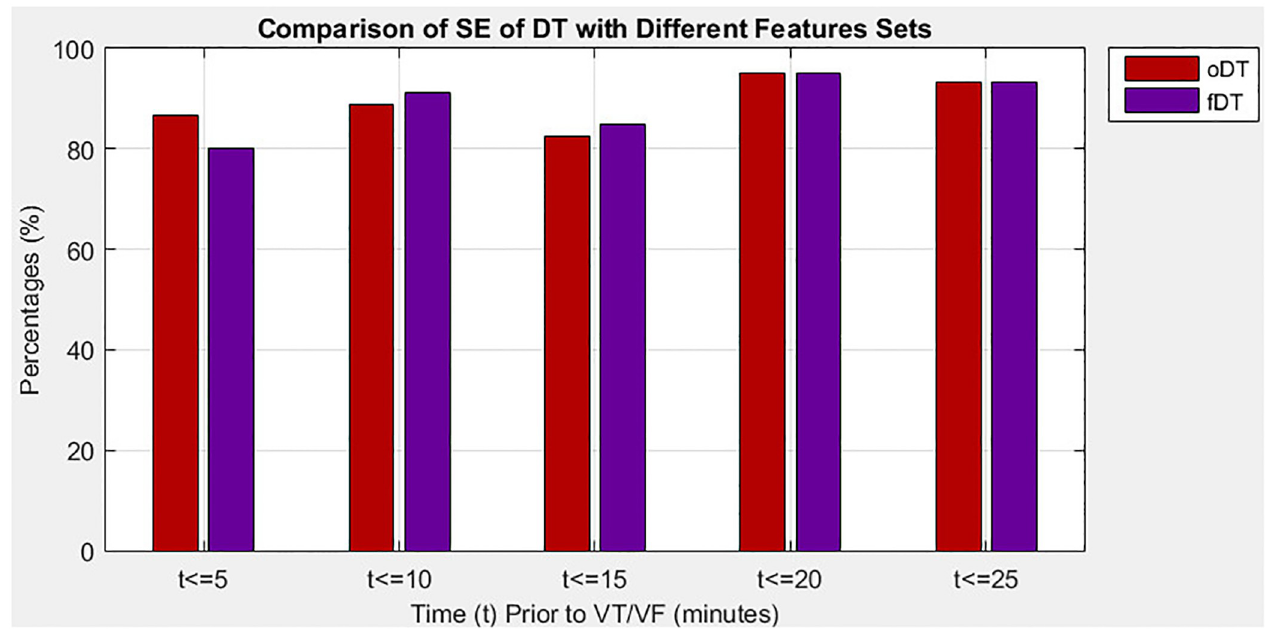
Fig 3. Comparison of SE for DT with different sizes of feature